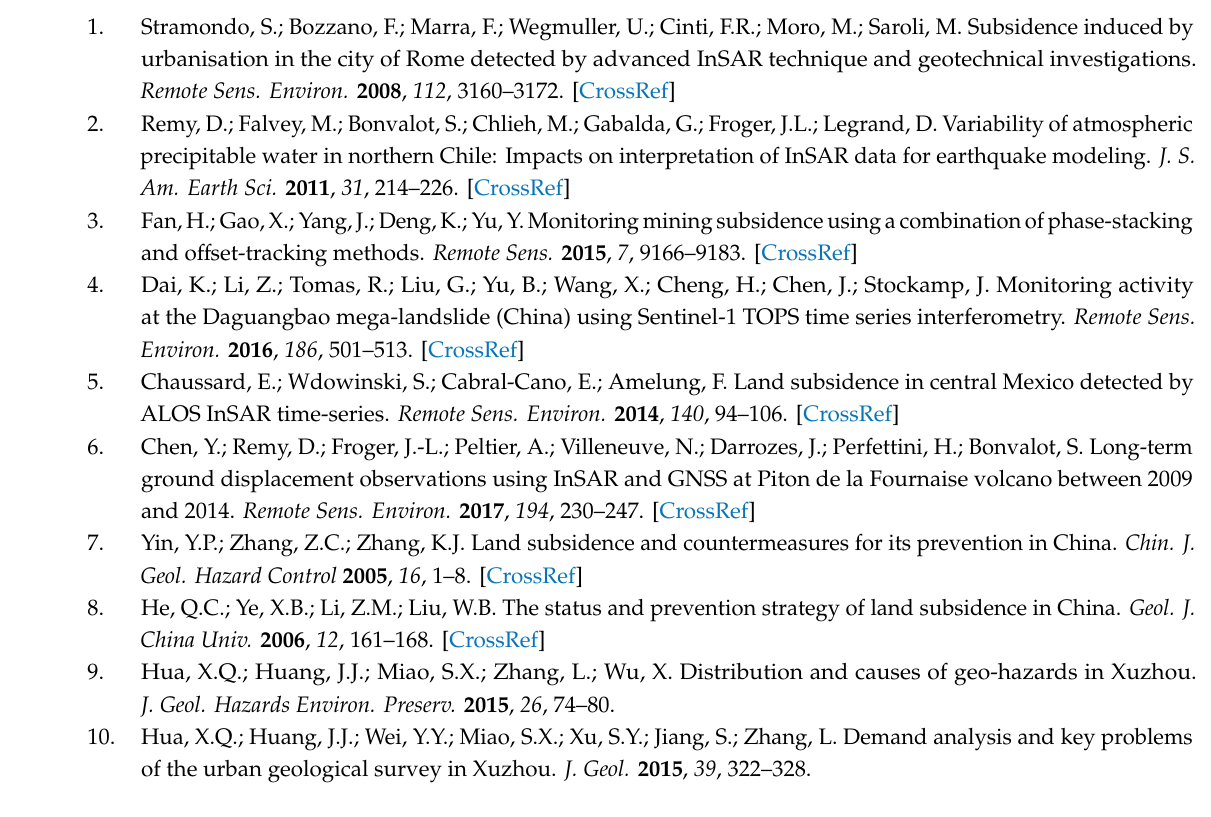
Figure S1: (a) Displacement rate map derived from initial InSAR time series for the entire study area during the period from November 2015 to June 2018. Positive values represent decreases in earth-satellite distance, while negative values represent increases in earth-satellite distance. Location of P1–P4 are indicated by black circles. Filled red star indicates the location of the reference area. The map conventions are the same as in Figure 4. (b) Displacement time series of points P1–P4. The red lines indicate the linear fits. Figure S2: Correlations between the PCs and the